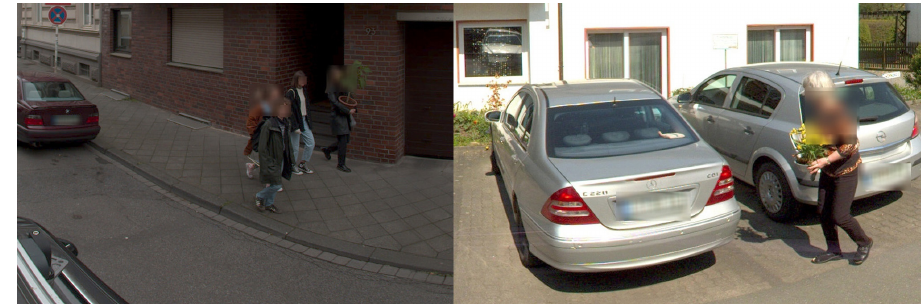
Figure 6. Examples of positive blurred panoramic images.